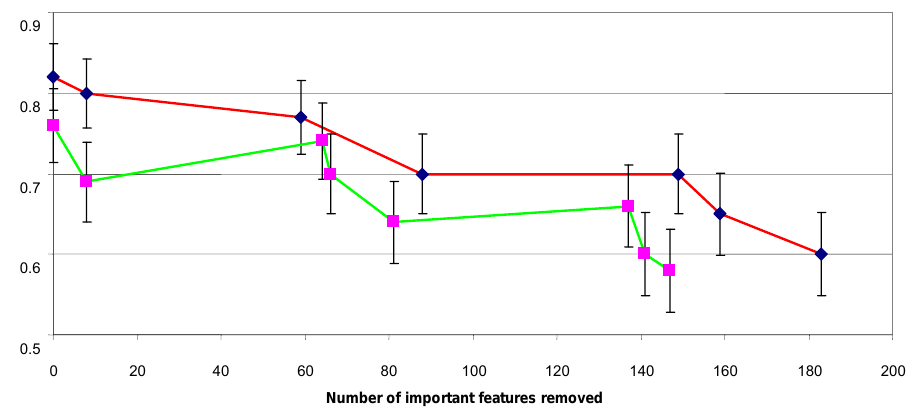
Figure 1: Decrease of nested CV performance (AUC) after removing important features iteratively. Procedure findImportantGenes is called twice. The first round for detecting genes with high average expression values in the non-pCR group (in red line). The second round for detecting genes with high average expression values in pCR group (in green line). The process stops when the nested CV performance (AUC) is below 0.60. Over 180 features were discovered in the first round and over 140 features were discovered in the second round. The nested CV performance is based on 10 times 5 fold CV for the inner CV (model tuning) and 5 times 5 fold CV for the outer CV (performance